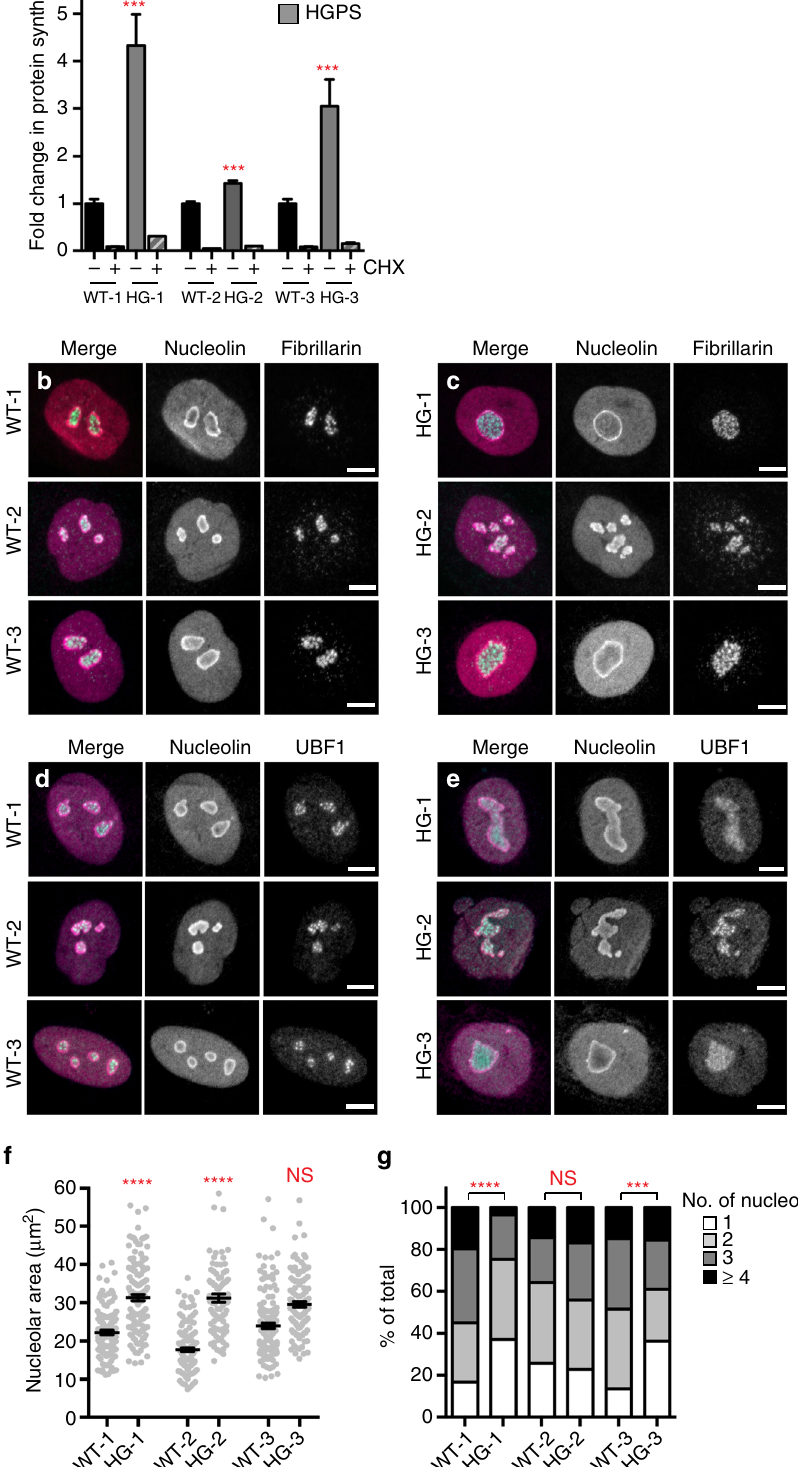
Fig. 2 Global translation is increased and nucleoli are enlarged in HGPS. a Analysis of global translation rates by 35 S-Met/Cys incorporation in WT and HGPS fi broblasts in the absence or presence of cycloheximide (CHX). Mean ± SEM of four independent experiments shown, each containing two technical replicates. *** indicates p < 0.001 by t -test. b – e Immuno fl uorescence of nucleolar proteins nucleolin ( magenta ) and fi brillarin ( cyan ) b , c or UBF1 ( cyan ) d , e in WT b , d ) and HGPS c , e fi broblasts. Scale bar , 10 μ m. f Total nucleolar cross-sectional area per cell, determined by boundaries of nucleolin immuno fl uorescence. **** indicates p < 0.0001 by t -test. Bars indicate mean ± SEM. g Number of nucleoli per cell. Signi fi cance determined by χ 2 -test of indicated samples. f , g N > 111 cells per condition from six independent experiments with two technical